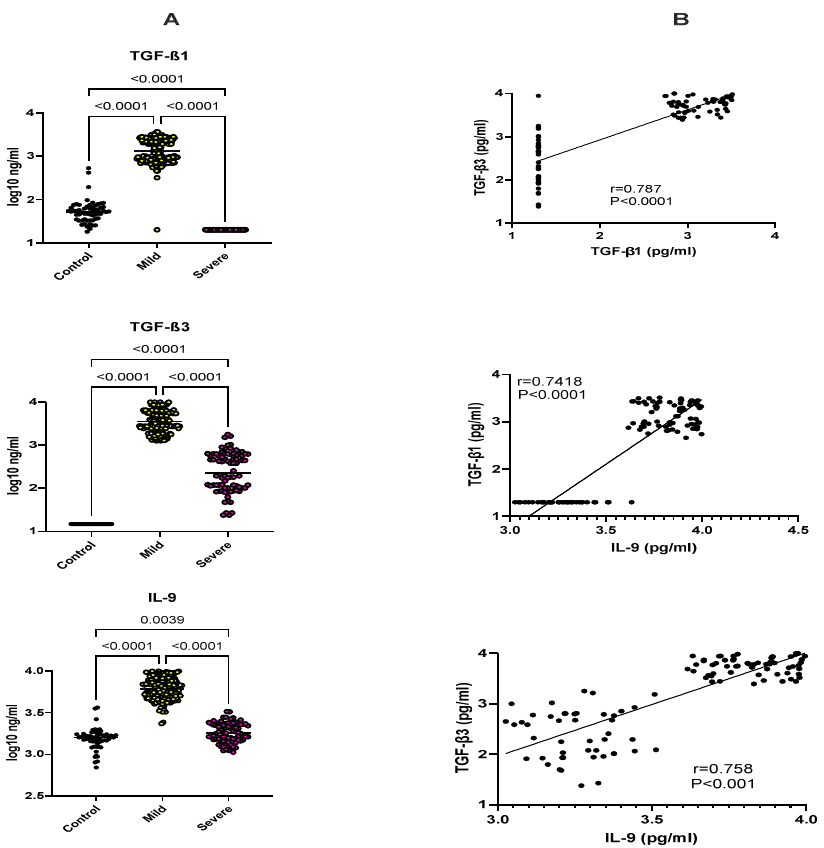
Figure 1. ( A ) TGF- β 1, TGF- β 3, and IL-9 levels in malaria patients. Plasma samples from a panel of control donors and mild or severe malaria patients were tested for TGF- β 1, TGF- β 3, and IL-9 by using ELISA. For TGF- β 1 and TGF- β 3 assays, samples were briefly exposed to 0.1 M acetic acid (Ph 3), followed by TRIS buffer (Ph8), before performing the ELISA. Statistical significance was calculated by one-way ANOVA; ( B ) correlation of TGF- β 1, TGF- β 3, and IL-9 plasma concentrations in individual mild and severe patients. Spearman r correlation coefficients are